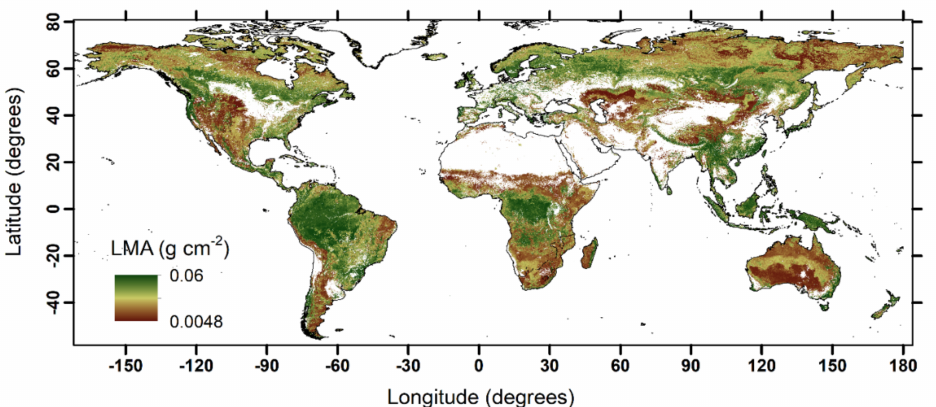
Figure 3. Global variation in LMA generated from MODIS reflectance product (MCD43A4) and WorldClim climatic data (temperature and rainfall) at 500 m spatial resolution using the random forest machine learning technique (R 2 = 0.58). Inversely retrieved from SLA based on [51]. Soil properties such as nutrient and water availability affect spatial patterns in